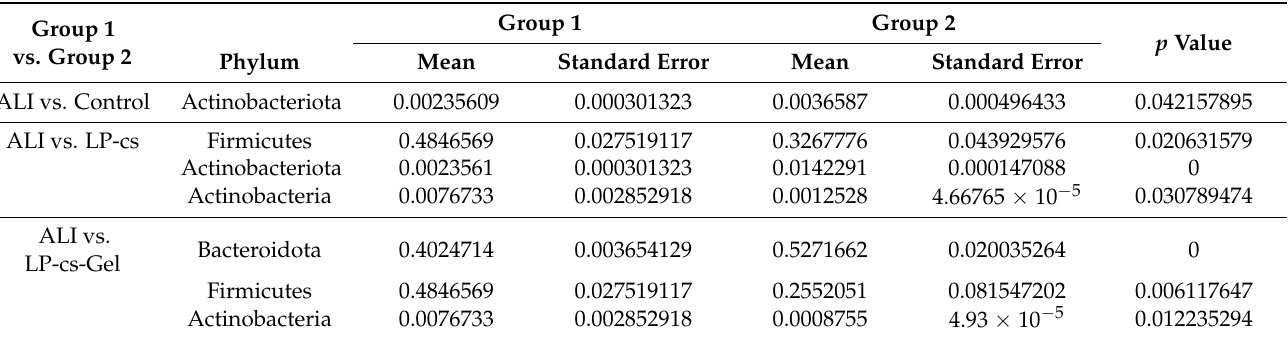
Table 3. Differences in composition at phylum level.